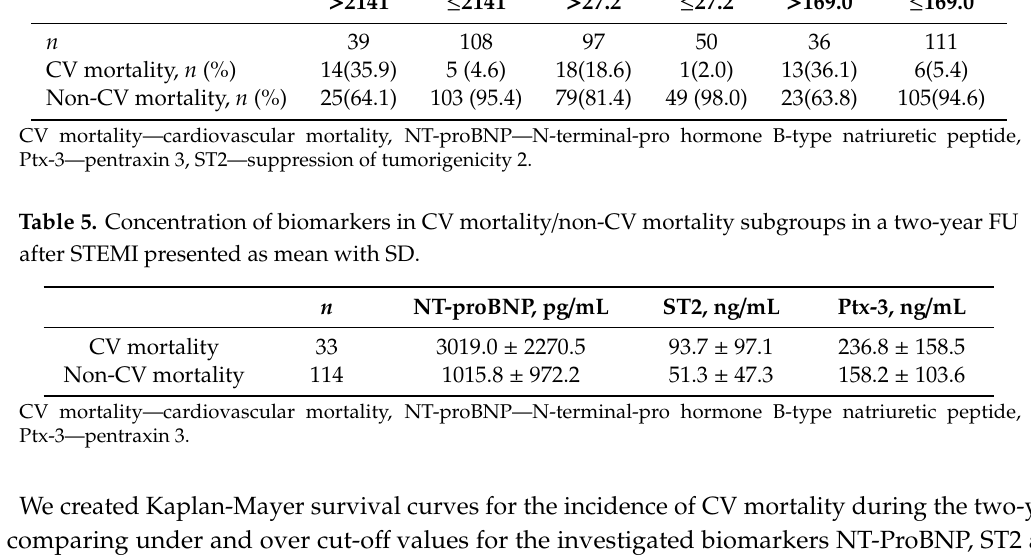
Table 4. CV mortality/survivals according to cut-off values in a two-year FU after STEMI ( p < 0.1) NT-proBNP, pg/mL